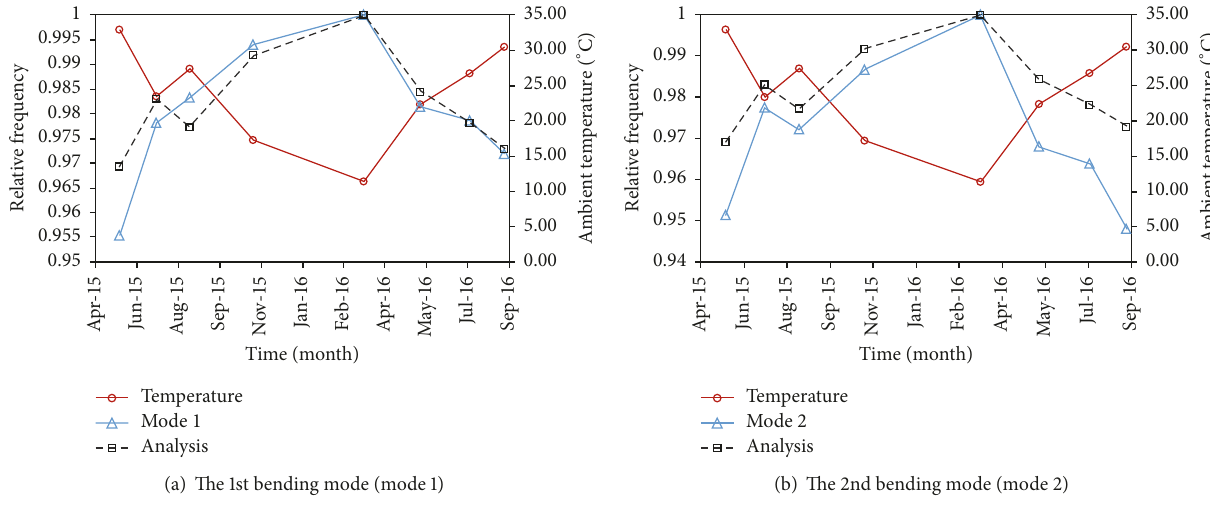
Figure 24: ((a)-(b)) Variations in two bending modal frequencies of girder No. 3 over one and a half